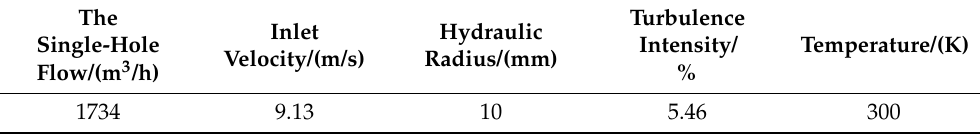
Table 2. Inlet parameters of ammonia injection.